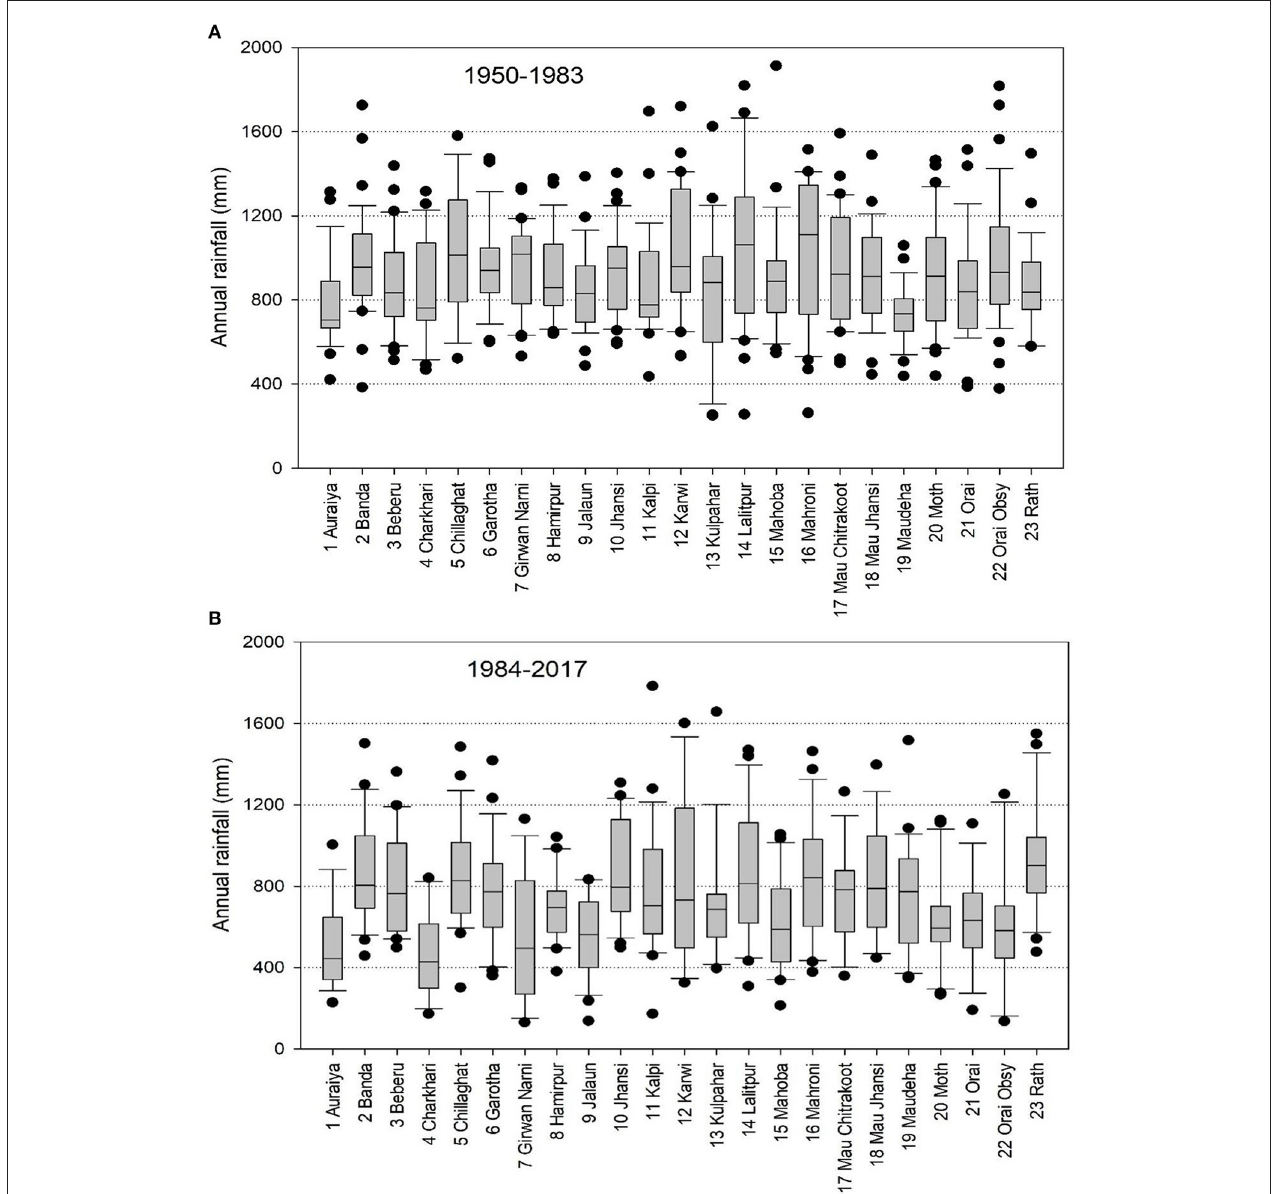
FIGURE 4 | Comparison of annual average rainfall of 23 stations in Bundelkhand region of Uttar Pradesh between (A) 1950–1983 and (B) 1984–2017.